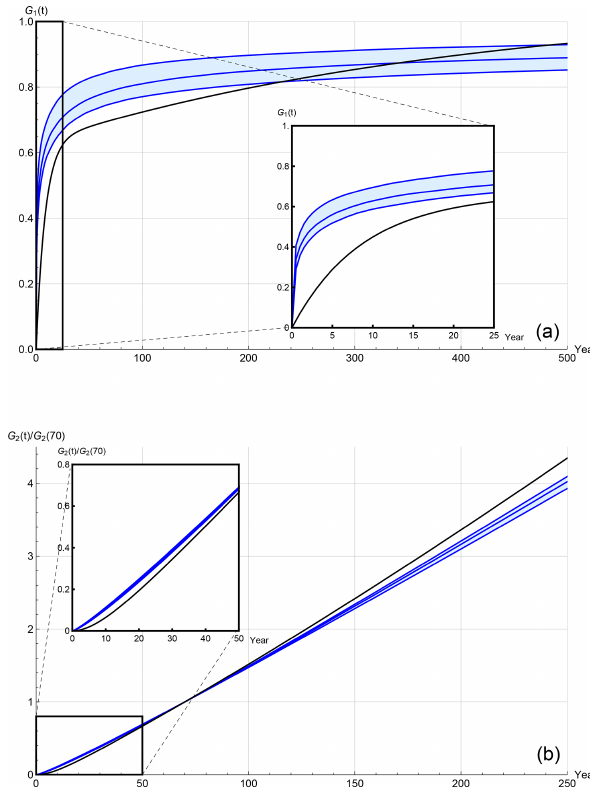
Figure 4. (a) The median and 90%CI of the FEBE step-response Green’s function, G 1 ( h,τ ; t ), compared to the IPCC two-box- model Green’s function (black). (b) The median and 90%CI of the FEBE normalized ramp-response Green’s function, G 2 ( h,τ ; t ), compared to the IPCC two-box-model Green’s function